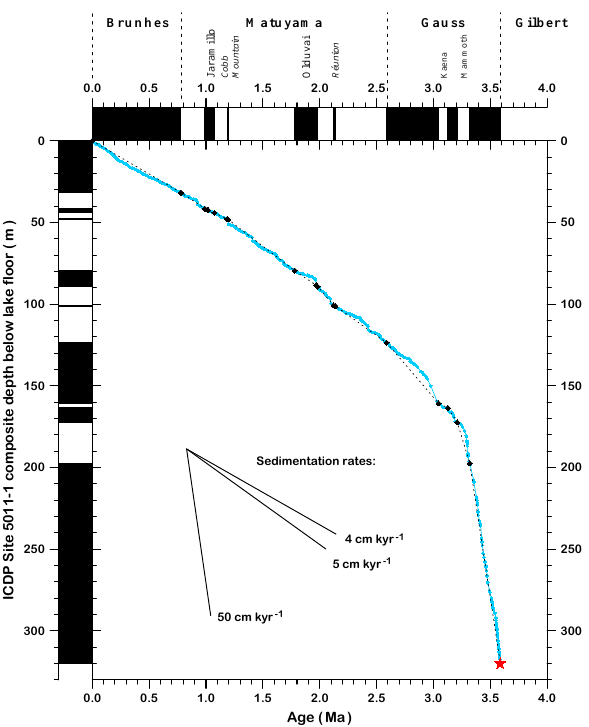
Fig. 7. Age depth model for the ICDP Site 5011-1 sedimentary composite record derived from tuning of physical, sedimentolog- ical, geochemical, and pollen records to the benthic oxygen iso- tope stack from Lisiecki and Raymo (2005) and the Northern sum- mer insolation according to orbital solutions provided by (Laskar et al., 2004), respectively. Initial 1st order tie points (black diamonds) were provided by a comprehensive magnetostratigraphic investiga- tion of ICDP Site 5011-1 cores (Haltia and Nowaczyk, 2013; see also Fig. 2). The red star marks the time of the impact inferred from 40 Ar/ 39 Ar dating (Layer, 2000) at 3.58 ( ± 0.04)ka. Black (white) denote normal (reversed) polarity.